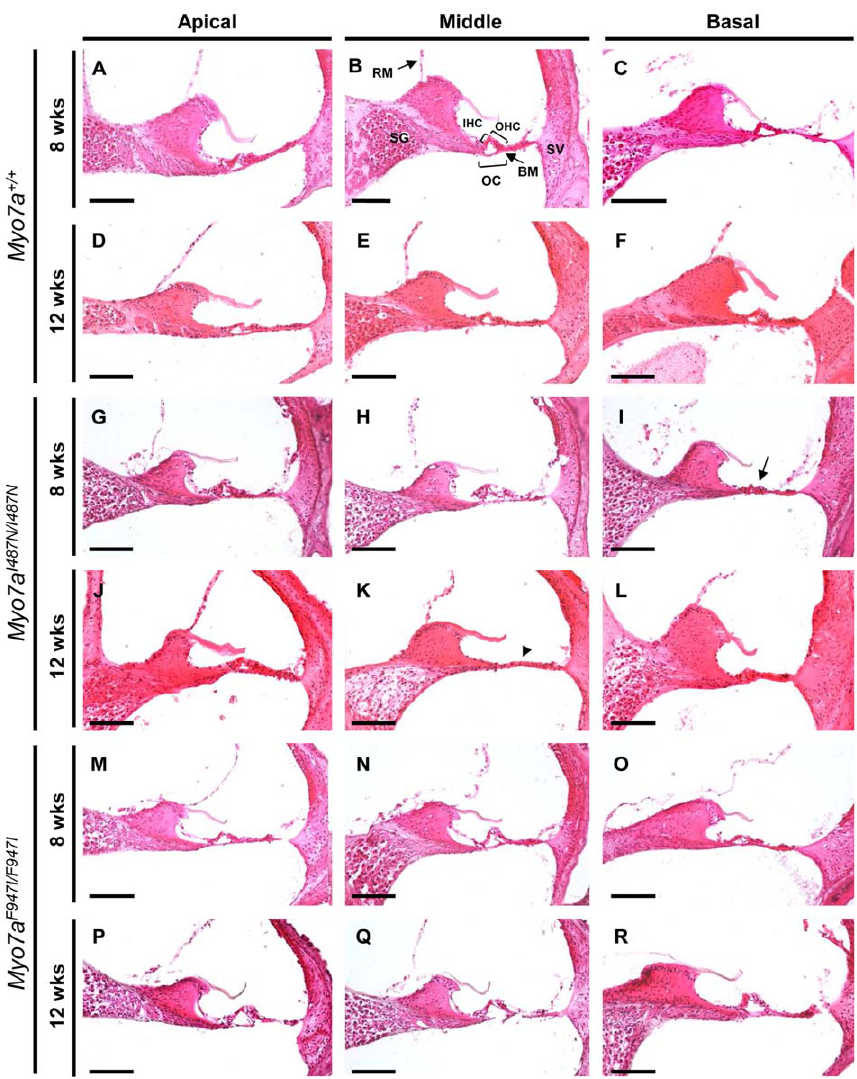
Figure 4. Haematoxylin and Eosin (H&E) staining of cochlear sections from Myo7a mutant strains at 8 and 12 weeks old. ( A–F ) Myo7a + / + , ( G–L ) Myo7a I487N/I487N ewaso and ( M–R ) Myo7a F947I/F947I dumbo mice at the apical, middle and basal levels. Normal cochlear